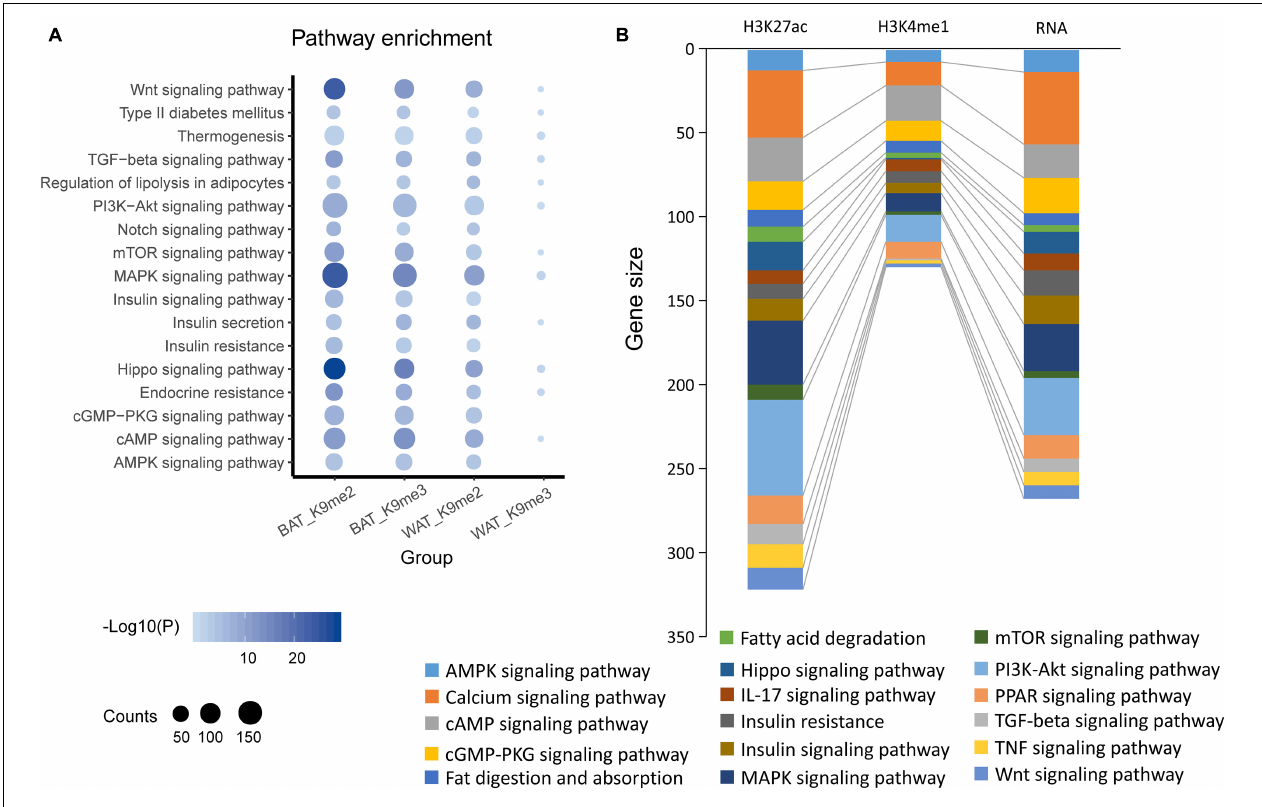
FIGURE 2 | KEGG pathway enrichments of BAT or WAT under SCD and HFD conditions. (A) KEGG pathway enrichment by genes showing differential peaks in promoter regions identified by H3K9me2 (K9me2) or H3K9me3 (K9me2) ChIP-seq of mouse brown adipose (BAT) or white adipose tissues (WAT) under HFD condition compared with SCD conditions. (B) KEGG pathway enrichment of H3K27ac, H3K4me1 and RNA-activated genes in brown adipose (BAT) or white adipose tissue (scWAT) under HFD condition compared with SCD